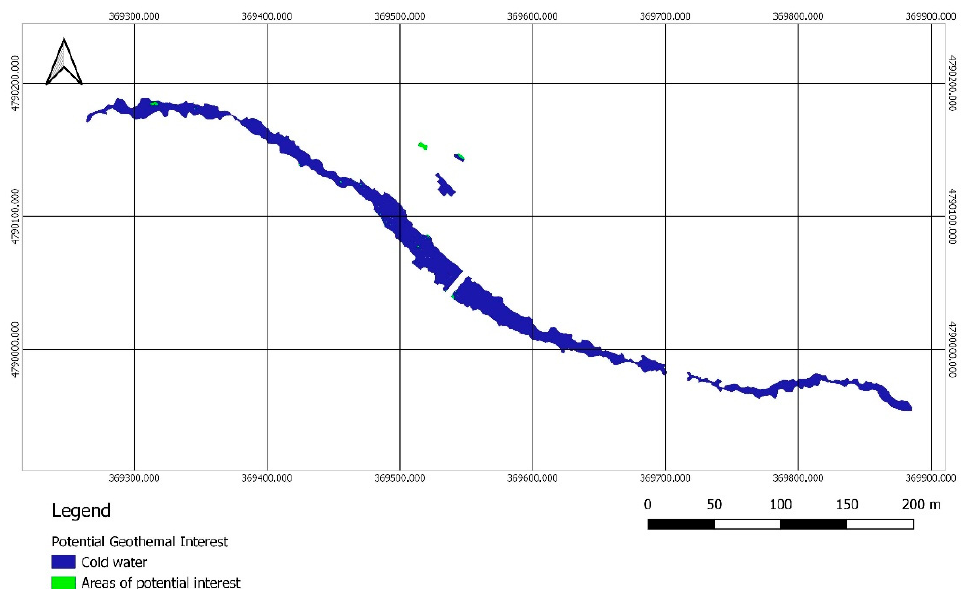
Figure 12. Orthomosaic representation of the potential geothermal interest areas. Reclassification for the set limit temperature of 32.75 °C. The areas of potencial interest are shown in green, while the cold water surfaces are represented in blue.